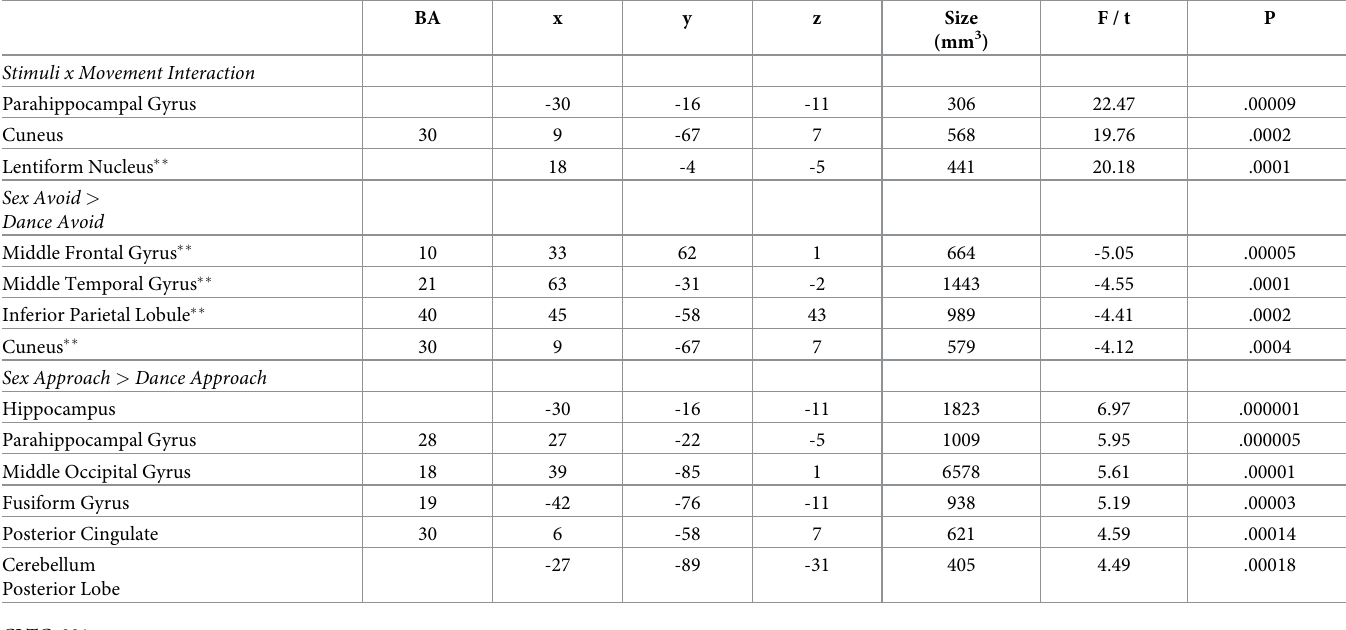
Table 2. Motivational sexual inhibition—Approach-Avoidance task.